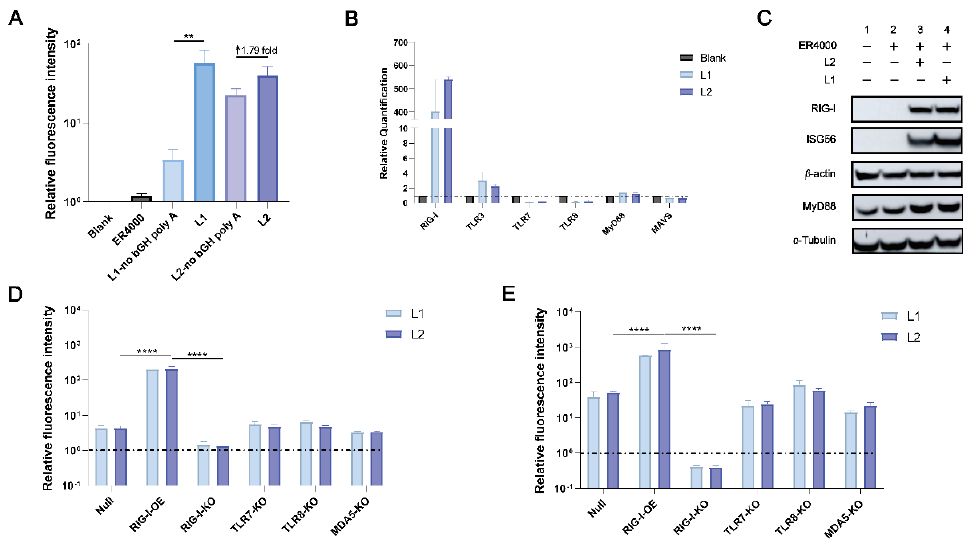
Figure 3. L1 and L2 activated the RIG-I signaling pathways in vitro. ( A ) The relative fluorescence intensity of Blank, ER4000, L1 − no bGH poly A, L1, L2 − no bGH poly A, and L2. ( B ) The relative expression of genes in Blank, L1, and L2 in A549. ( C ) Western blotting of A549 post − transfection with L1 and L2. Three independent experiments were repeated with similar results. ( D , E ) The relative fluorescence intensity of 293T null, 293T RIG − I overexpression ( RIG − I − OE ) , RIG − I -/- 293T, TLR − 7 -/- 293T, TLR − 8 -/- 293T, and MDA5 -/- 293T at 24 and 48 h post − transfection with L1 and L2. ( D ) 24 h. ( E ) 48 h. **, p < 0.01. ****, p < 0.0001. ↑ , increase. ER4000 is a kind of transfection reagents